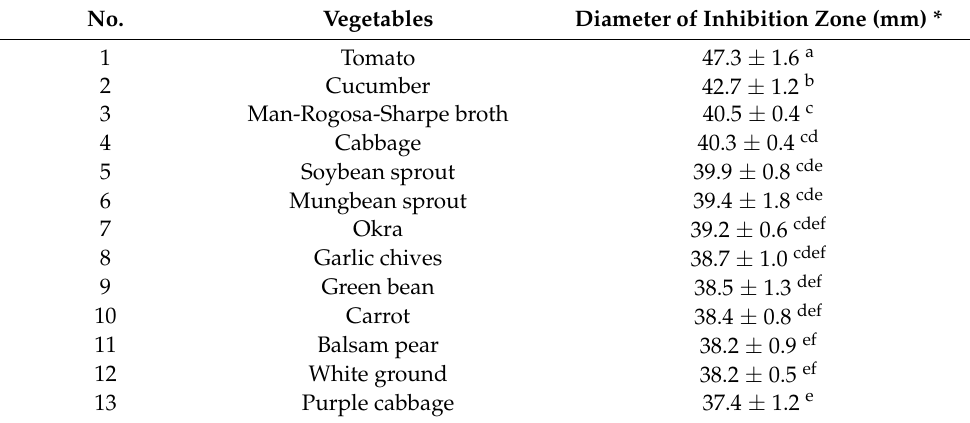
Table 1. Statistics of inhibition zone diameter of L. paracasei WX322 fermentation products from 12 kinds of vegetables after 5-fold